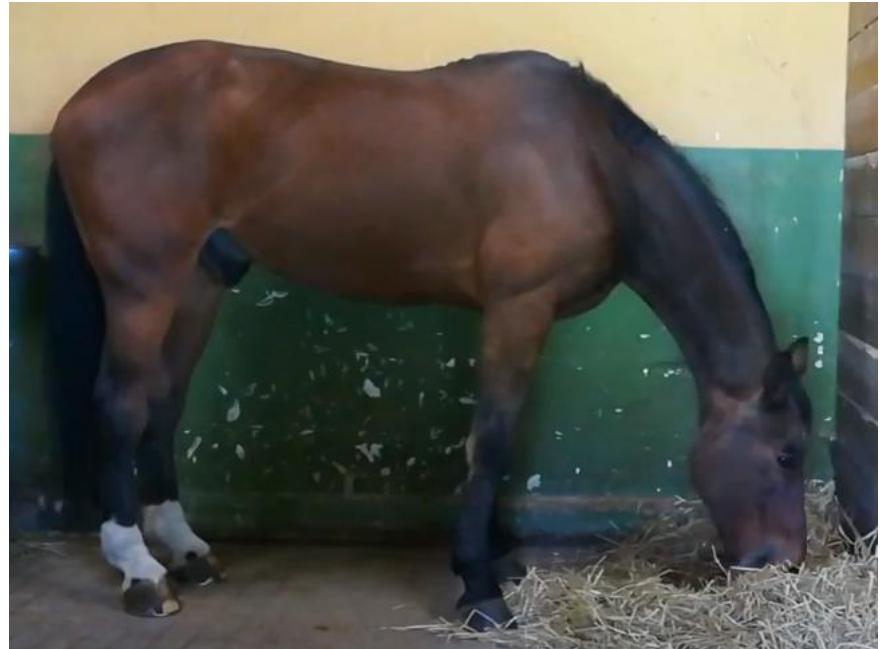
Figure 1. Control position (CP). Hay is on the ground. Since the height at withers varied between the participating horses, the other feeding positions set for each horse were established by hanging the hay nets at two different heights determined as follows: